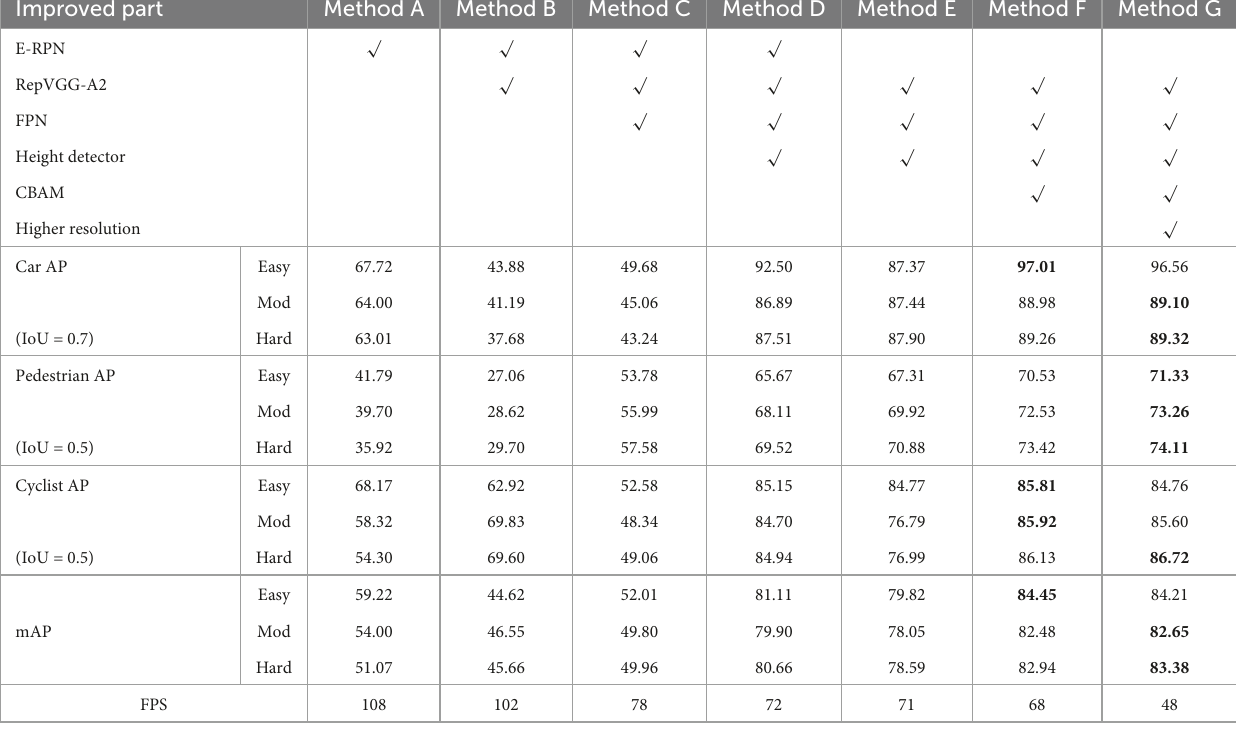
TABLE 3 Experimental results of the ablation experiments were used to verify the contribution of the improvements in this paper.